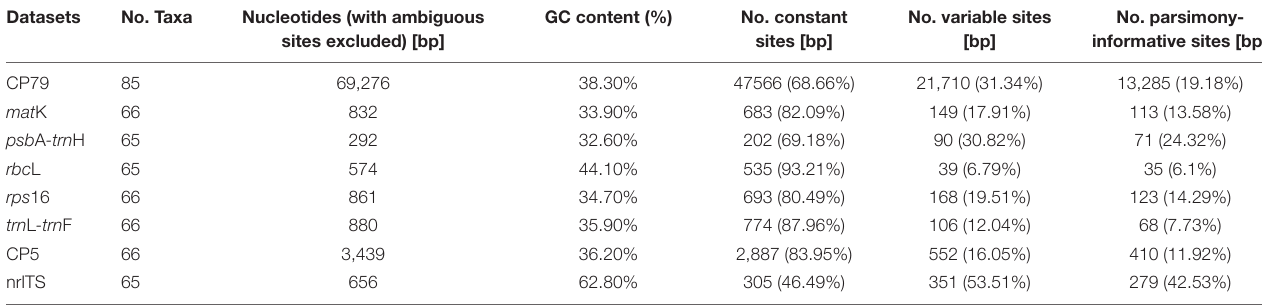
TABLE 2 | The statistics of all datasets for phylogenetic analysis. Datasets